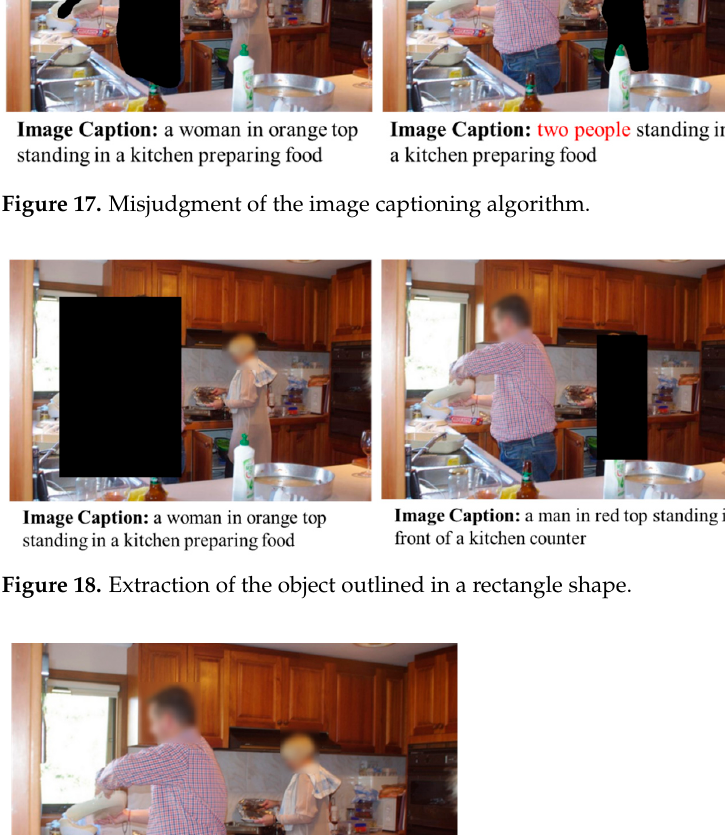
Figure 16. Image captioning result of an image containing two similar objects.